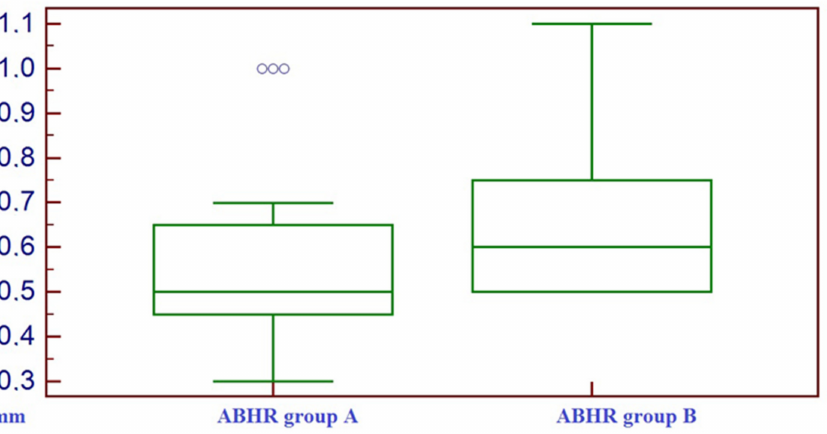
Figure 6. Box–whisker plot representing the distribution of alveolar bone height reduction (ABHR) on group A and on group